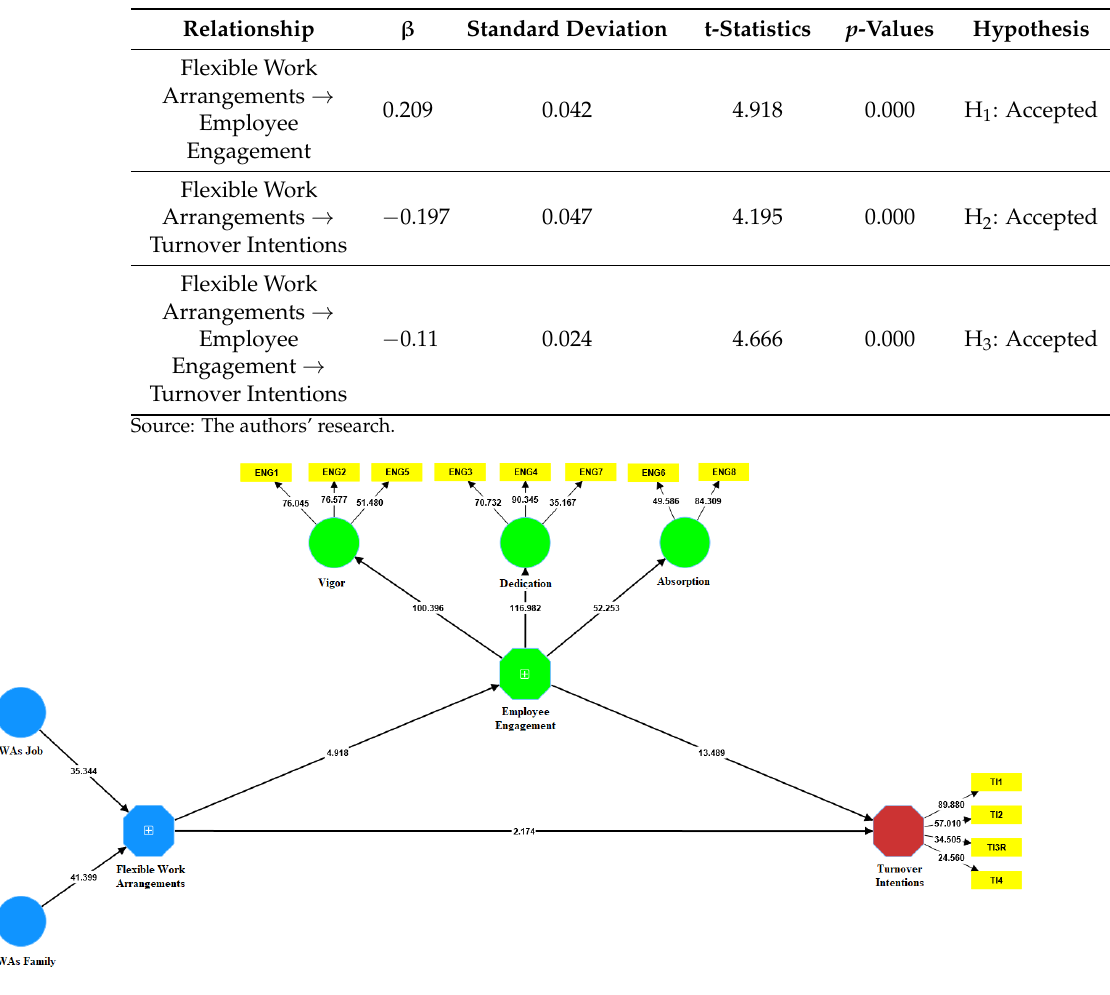
Figure 2. The path model with bootstrapping result. Source: The authors’ research.